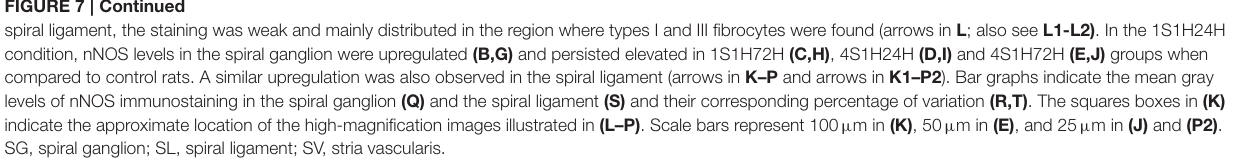
B.V.). Images were captured using a DXM 1200C digital